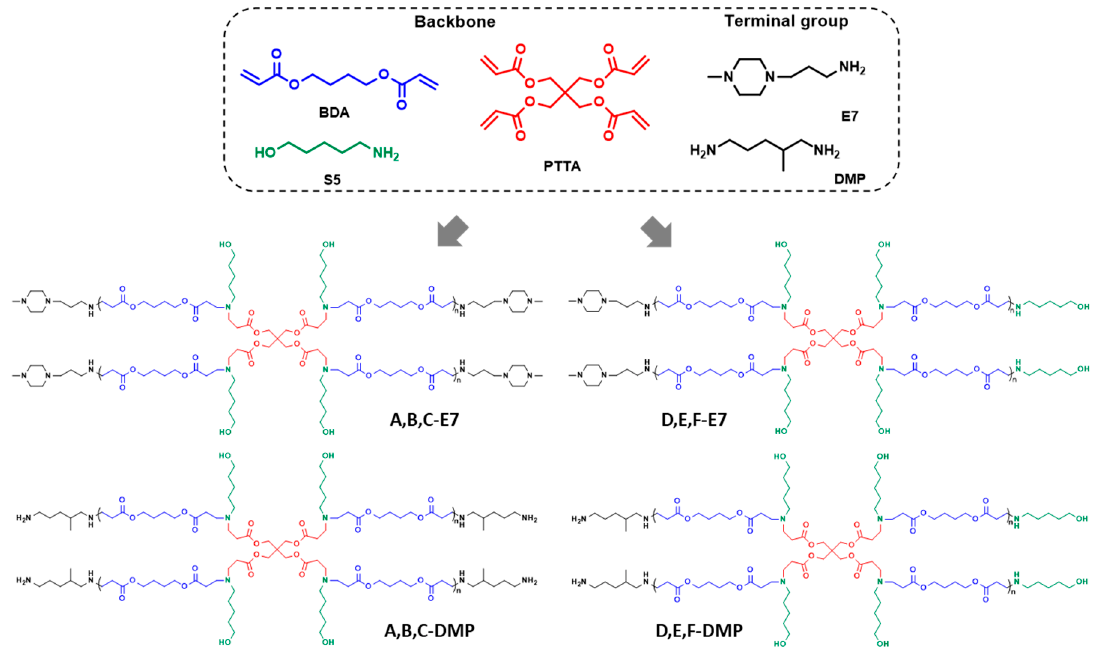
Figure 1. The chemical structures of monomers and HPAEs selected for the study. GPC results displayed that A, B, C-E7 and D, E, F-E7; A, B, C-DMP and D, E, F-DMP had similar molecular weight and PDI. As shown in Table 1, A-E7, D-E7, A-DMP, and D-DMP all exhibited M w around 7 k Da. The second molecular weight rank was B-E7, E-E7, B-DMP, and E-DMP, exhibiting M w around 10 k Da. For the C-E7 and F-E7, the M w was